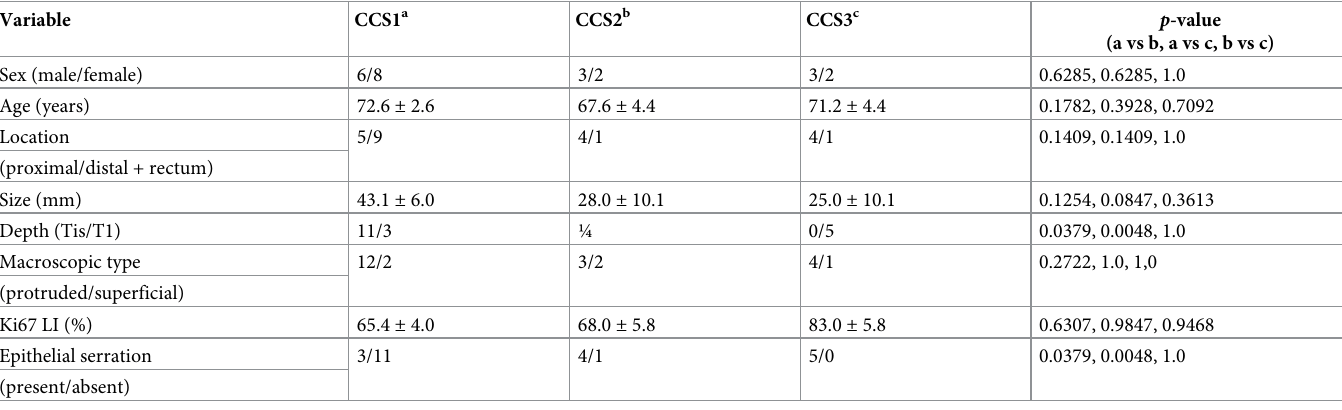
Table 1. Clinicopathological characteristics of SACs for each molecularly distinct